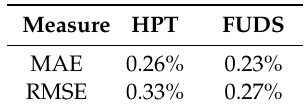
Table 2. Algorithmic performance on SOC estimation for the simulation study.